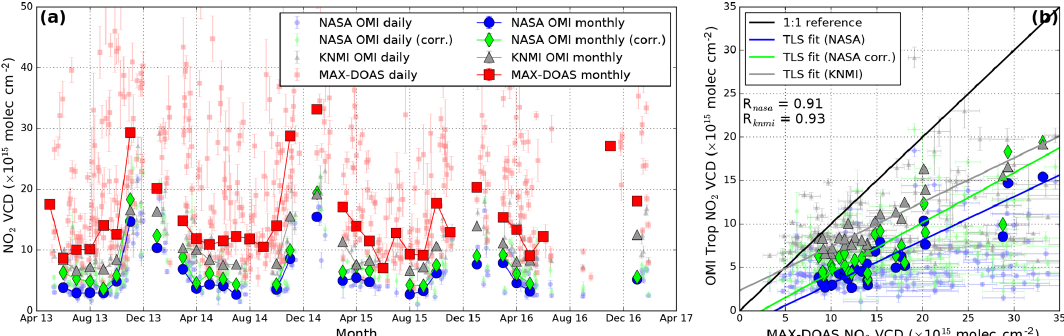
Figure 4. (a) Time series of the MAX-DOAS (red markers) and NASA OMI (blue markers) tropospheric NO 2 VCDs over Nanjing from 2013 to 2017. MAX-DOAS data are temporally averaged around the OMI overpass time. OMI measurements are spatially averaged for pixels within 20km of the MAX-DOAS measurement site. OMI NO 2 VCDs retrieved using MAX-DOAS profile as a priori information are indi- cated as green markers. Tropospheric NO 2 VCDs taken from a KNMI product are also shown as gray marker for reference. (b) Comparison of tropospheric NO 2 VCDs between the MAX-DOAS and OMI satellite observations. The total least squares regression line is calculated based on the monthly average data.